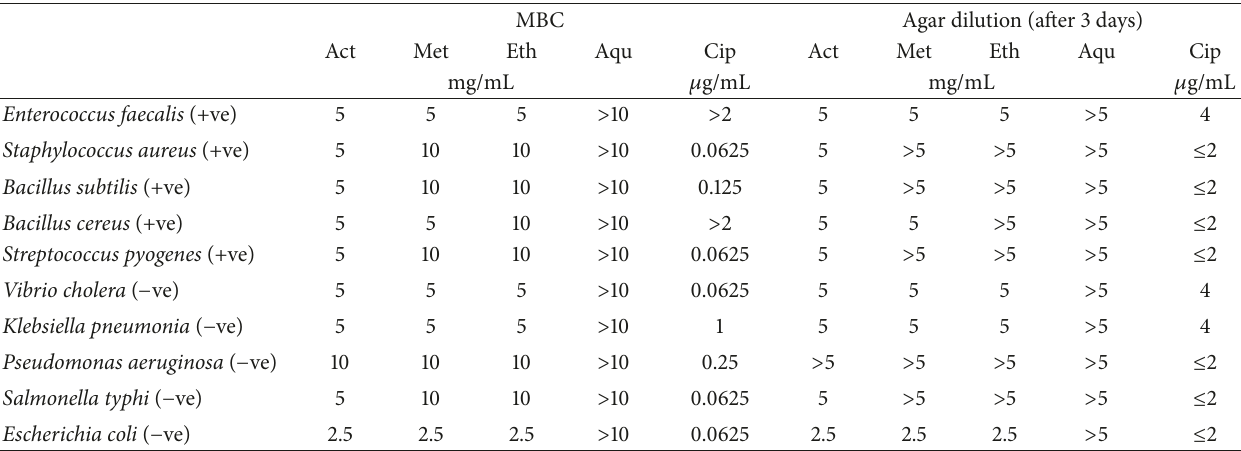
Table 2: Minimum Bactericidal Concentrations (MBC)and MICof the agar dilution after 3 days of incubation of thedifferent solvent extracts of P. capitata on selected gram-negative and gram-positive bacteria. MBC